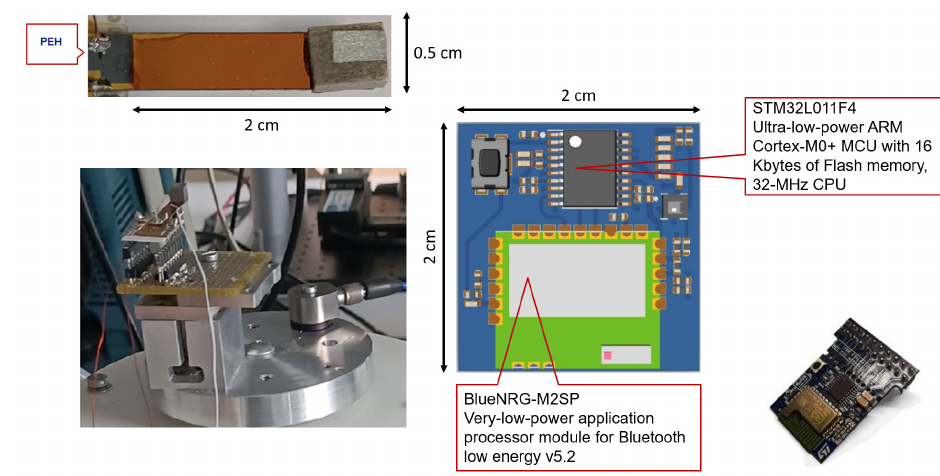
Figure 7. Experimental setup, EAWVS PCB and PEH.